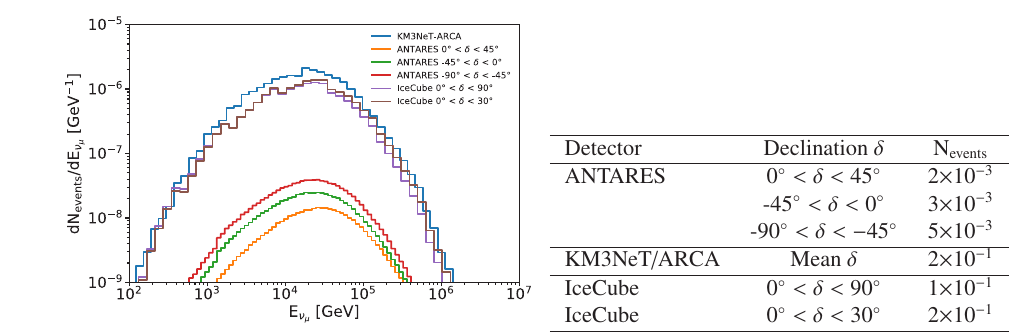
Table 1: Expected total number of events induced in neutrino telescopes by ν µ from an individual choked GRB. The numbers in the table are obtained by inte- grating the curves in Fig. 1.